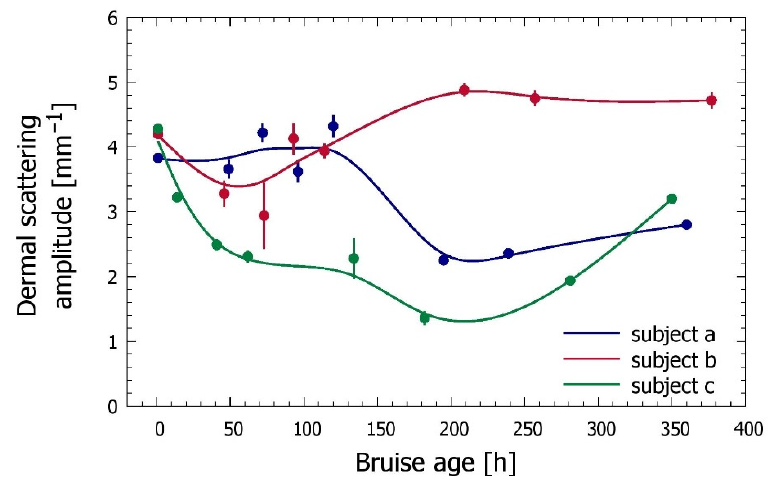
Figure 9. Comparison of the assessed time evolution of the dermal scattering coefficient ( a der ) in three included subjects.